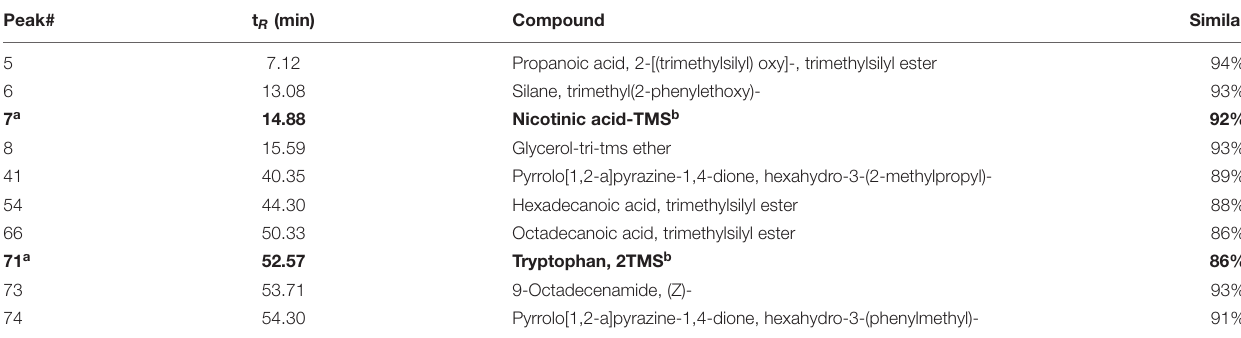
TABLE 3 | Identified compounds by GC-MS presented in S. mutans fraction (SM-F2). Peak#